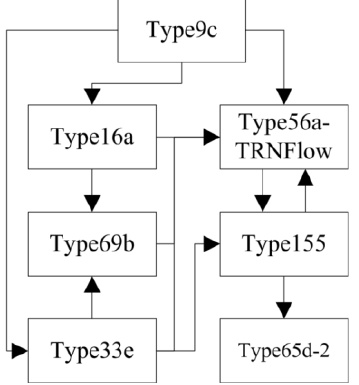
Energies 2016 , 9 , 1090